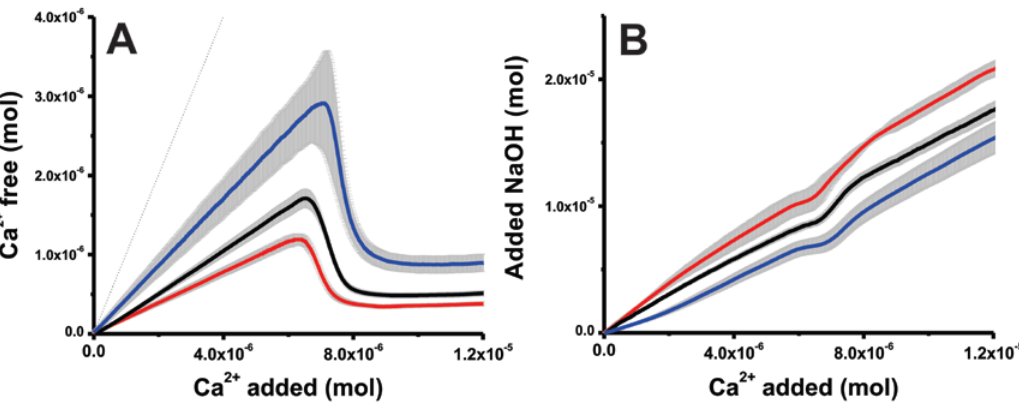
Figure 1. Developments of ( A ) free Ca 2+ ions and ( B ) added NaOH contents for titrations performed at pH 9.75 in absence of additives (black) and the presence of either 10 mM urea (red) or trehalose (blue) in relation to the total Ca 2+ ion contents. Zones shaded grey represent ± 1 standard deviation for triplicate experiments. ( A ) The dotted line represents the development of total amount of Ca 2+ ions dosed into the buffer.